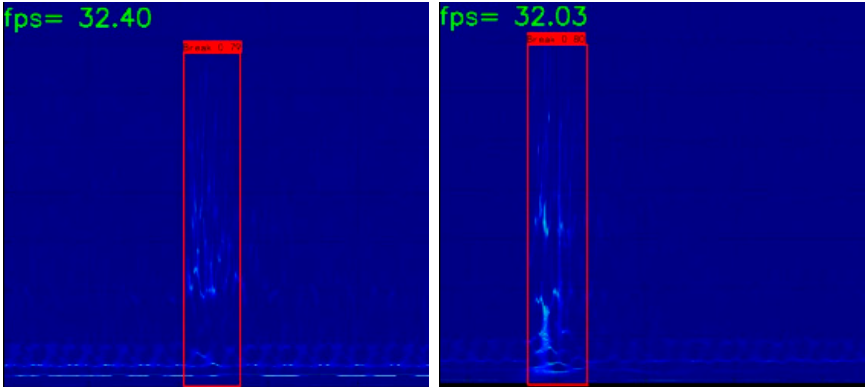
Figure 12. Examples of wire break detection results based on pruned YOLOXs.